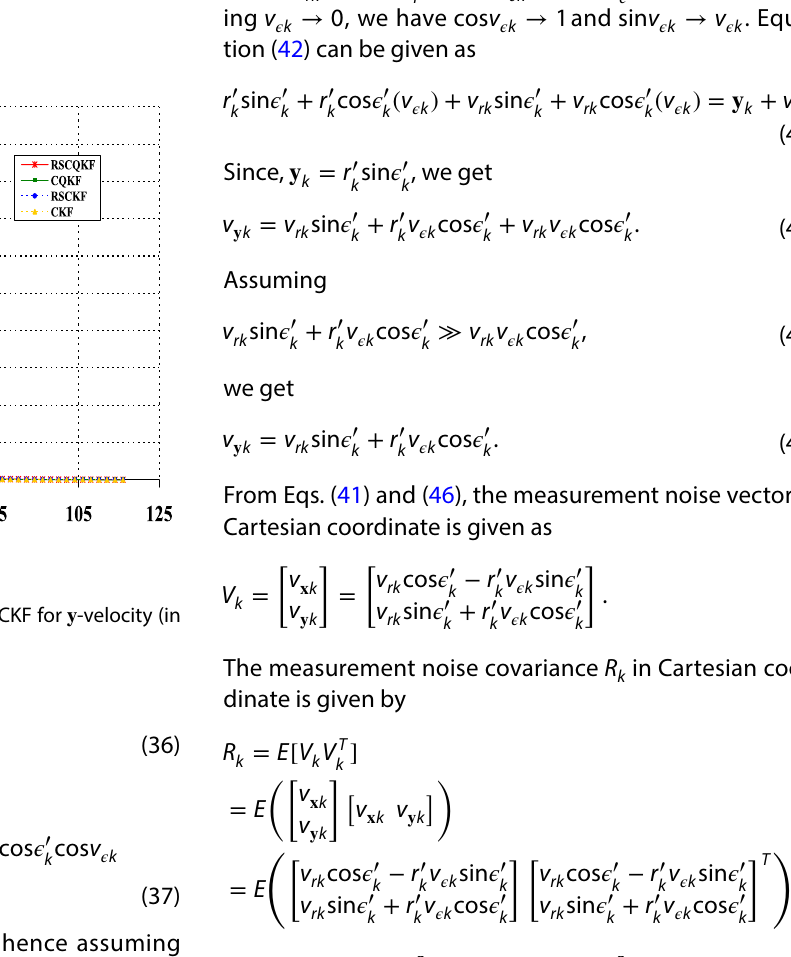
Fig. 8 RMSE plot of RSCQKF, RSCKF, CQKF and CKF for 𝐱 -velocity (in km/s) of the target